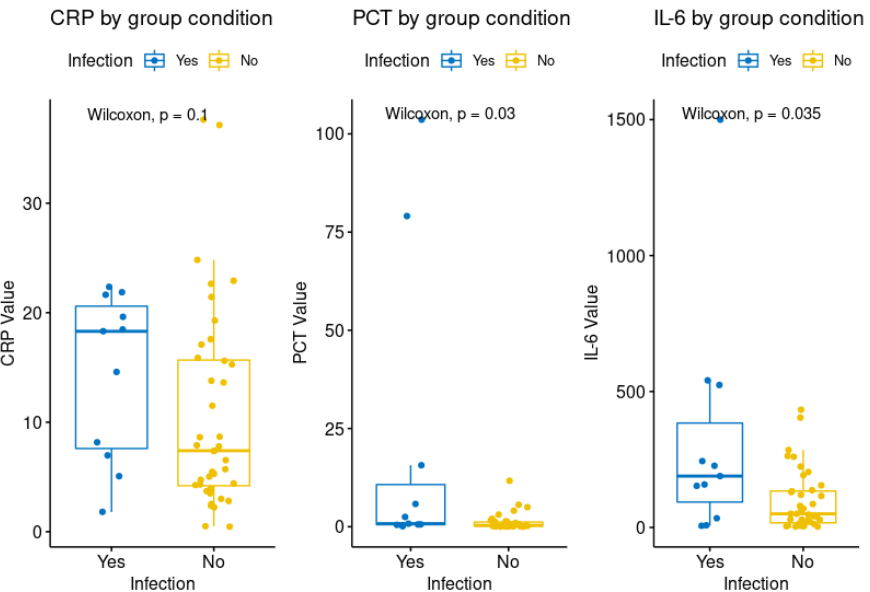
Figure 2. Boxplot and statistical significance of biomarkers for group 1 (no infection) and group 2